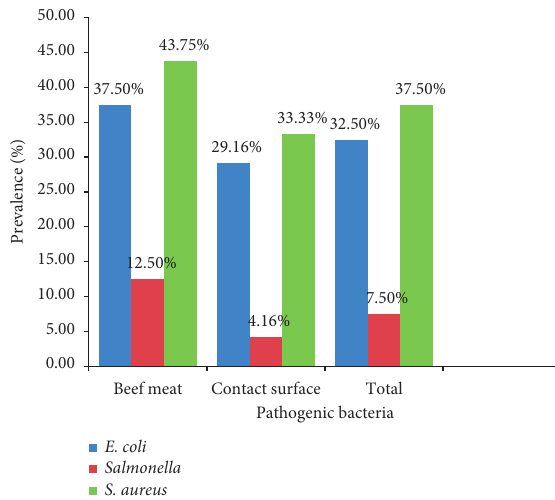
Figure 1: Prevalence of pathogenic bacteria in beef meat and swabs from contact surfaces. Table 7: Biochemical test for total aerobic mesophilic bacteria.